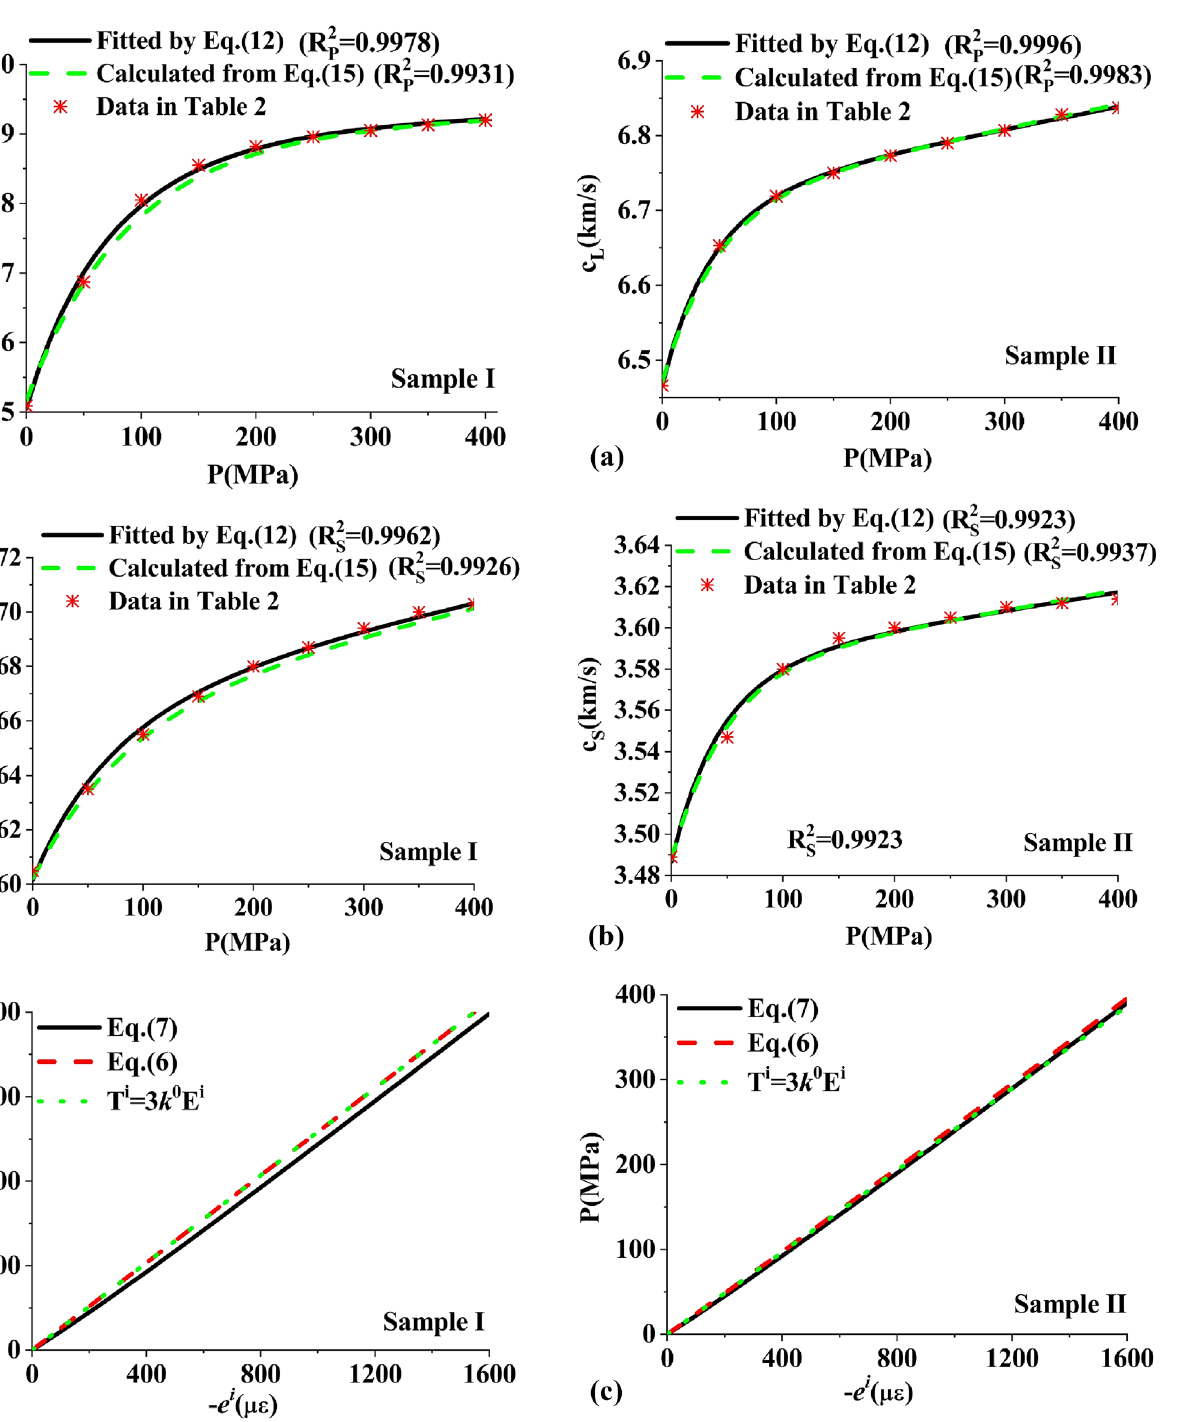
Fig. 2 Fitted results by Eq. (12), the calculated results by Eq. (15) and corresponding constitutive law for sample II, where P = − T i and e i = − 1 + √ 1 + 2 E i . a P-wave, b S-wave, and c constitutive